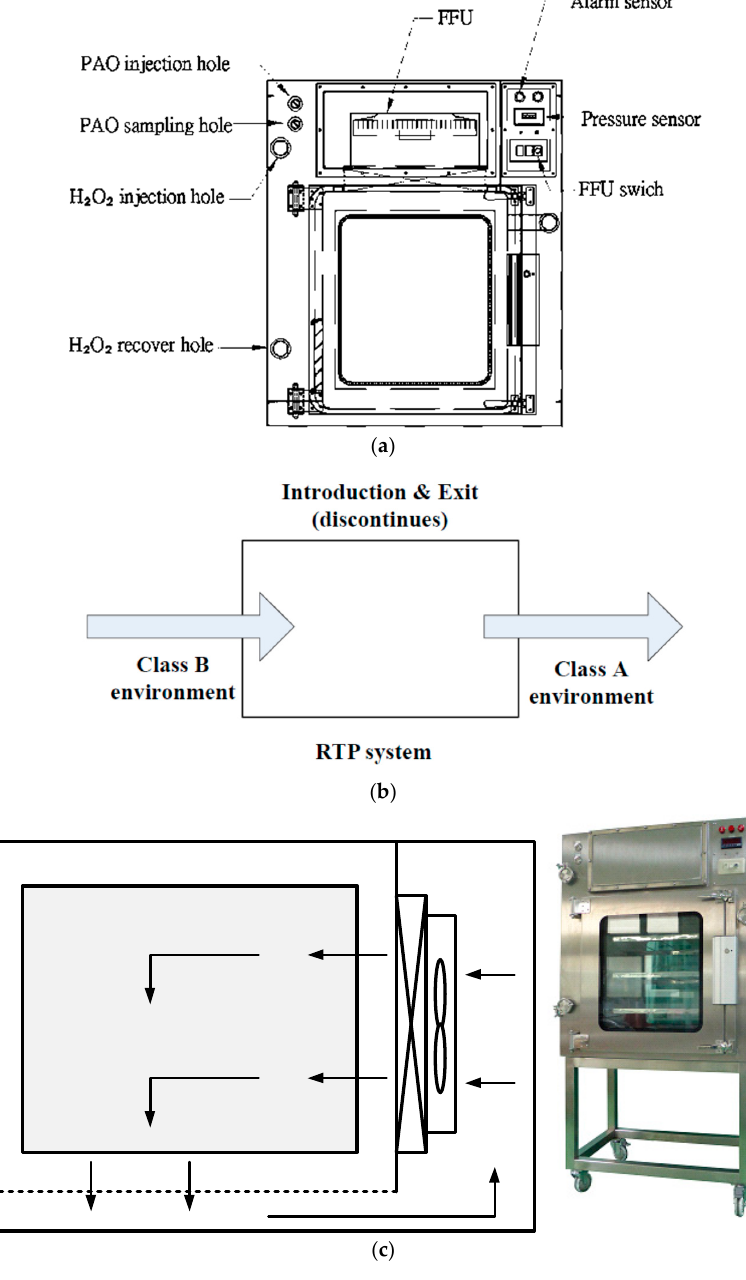
Figure 1. Rapid Transfer Port Chamber (Air System Enterprise Co., Ltd., Taoyuan, Taiwan; Self-Fabricated) ( a ) Schematic; ( b ) Material transfer function; ( c ) Air distribution.